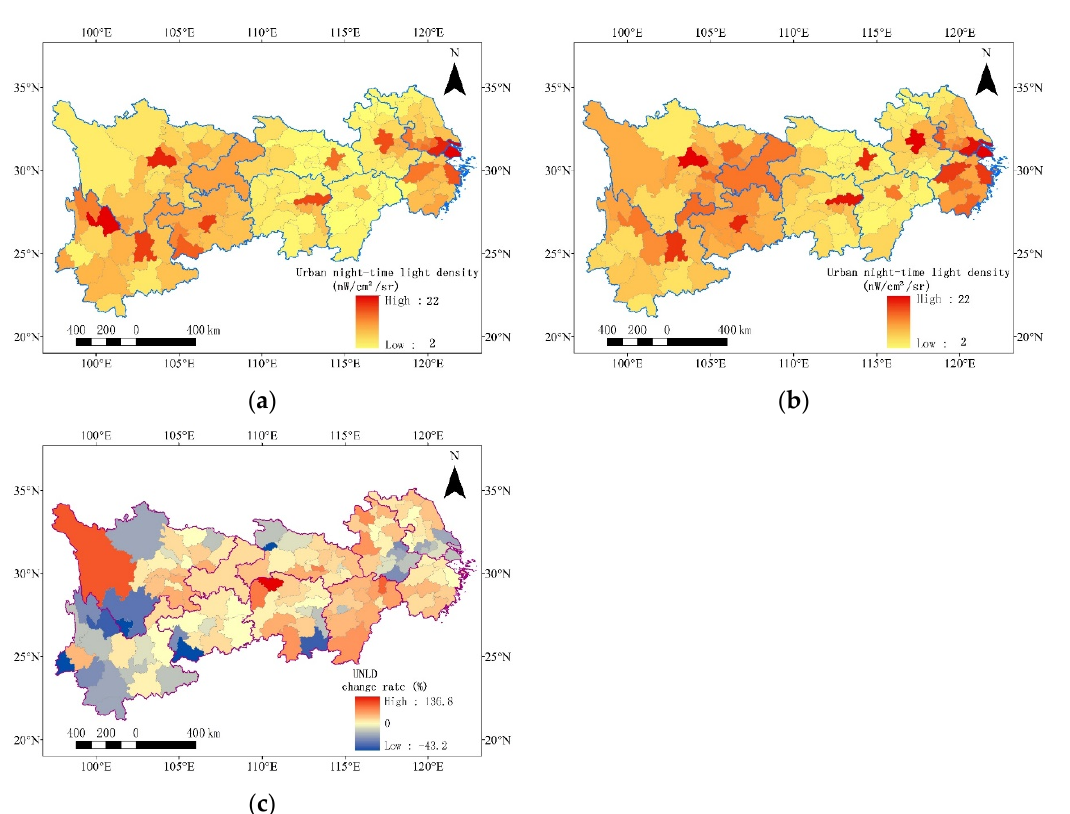
Figure 11. The urban night-time light density (UNLD) of YREB: ( a ) 2012; ( b ) 2019; ( c ) change rate.